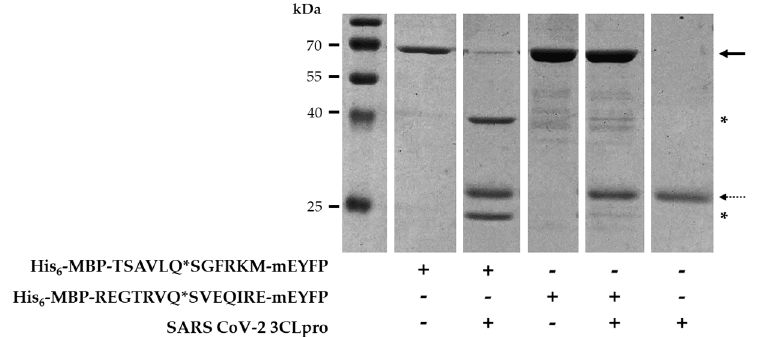
Figure 8. Cleavage of recombinant fusion protein substrates by SARS-CoV-2 3CLpro. His 6 -MBP-mEYFP substrates containing TSAVLQ*SGFRKM (SARS-CoV-2 nsp4) or REGTRVQ*SVEQIRE (CTBP1) cleavage site sequences were digested with SARS CoV-2 3CLpro. After SDS-PAGE, the gel was stained with Coomassie dye. Uncleaved proteins and SARS-CoV-2 PR are shown by continuous and dashed lines, respectively, while asterisks indicate cleavage products. Gel images are representatives of ≥ 2 parallel experiments.